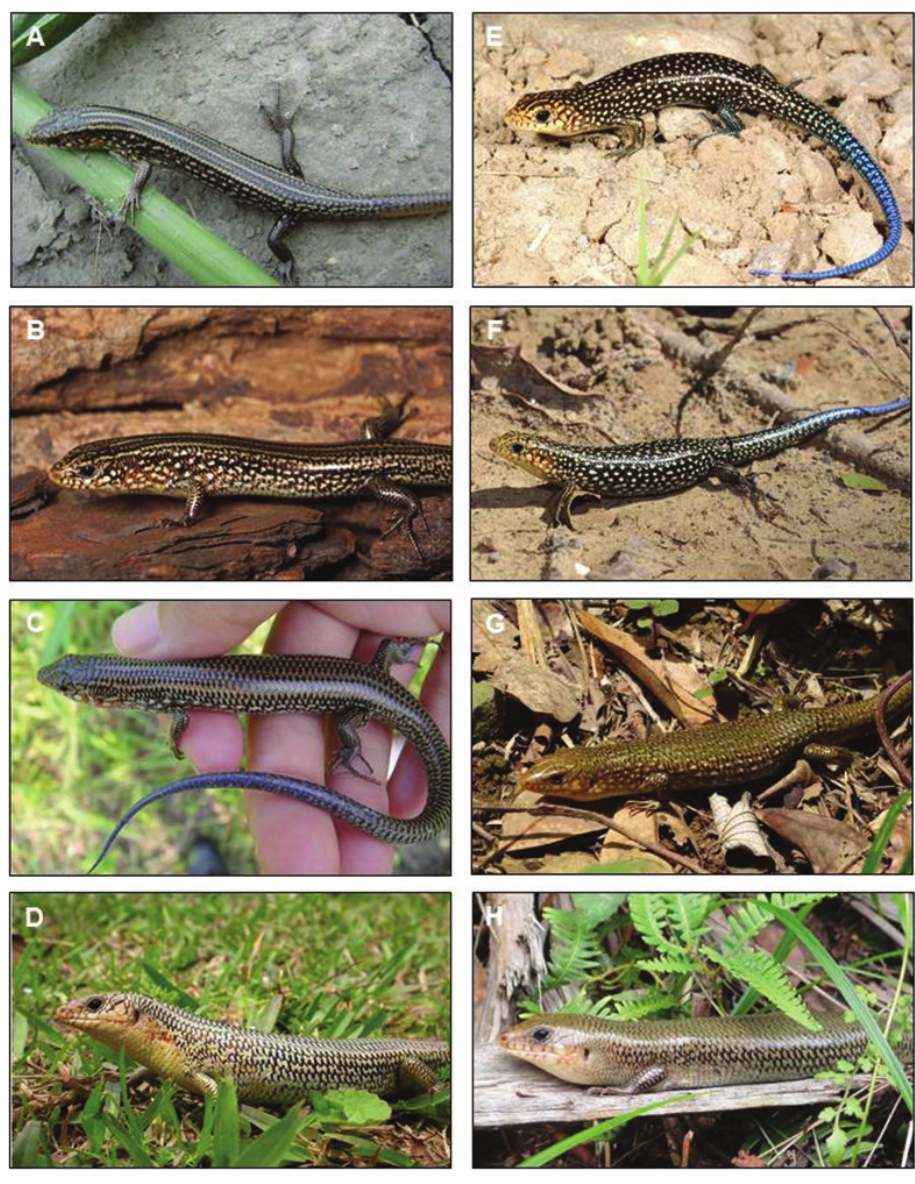
Figure 2. Color pattern alteration of Plestiodon chinensis formosensis (left, from western Taiwan) and P. c. leucostictus (right, from Green Island). Hatchlings ( A vs. E ), juveniles ( B and C v.s. F and G ), and adults ( D v.s. H ). Photographed by H.-Y. Tseng A, C, G, H ; R.-J. Wang B, F ; S.-M. Lin D ; and C.-W. You E